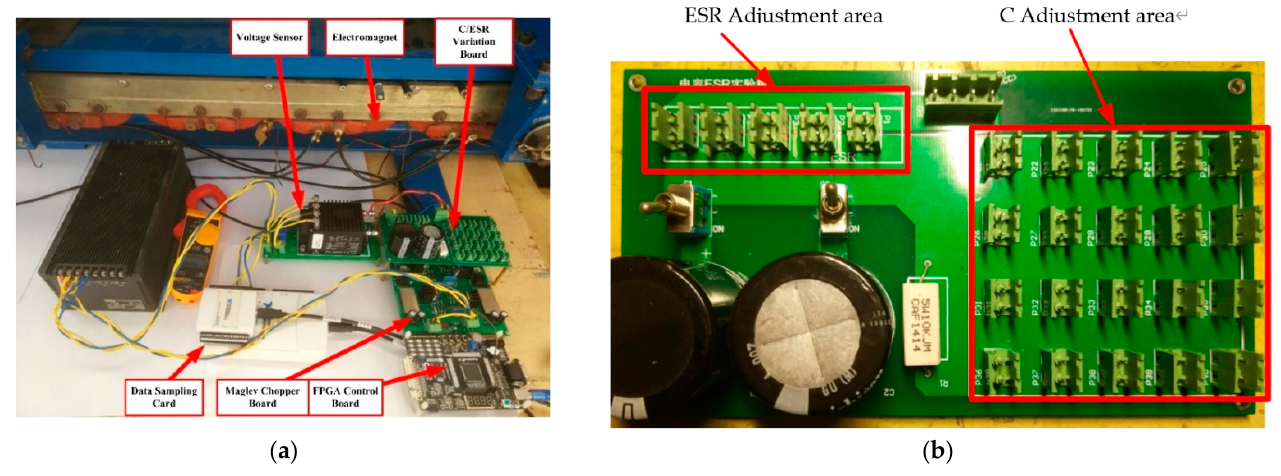
Figure 8. ( a ) A scaled Maglev train systems showing the test rig for the experiment ; ( b ) The C/ESR Variation Board.